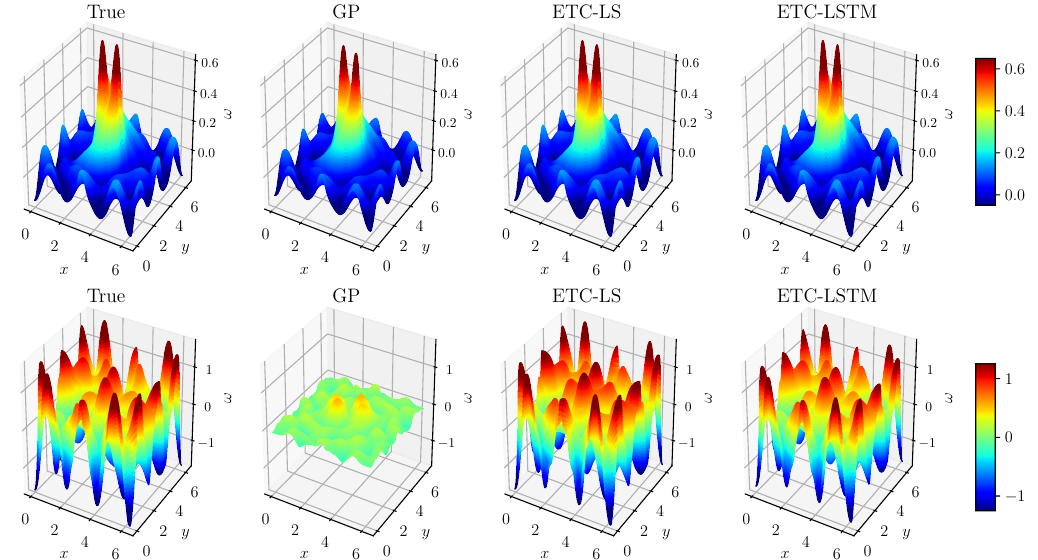
Figure 12. Vorticity field at the final time t = 20 for Re = 1000, γ = 0.01 ( top ) and γ = 0.1 ( bottom